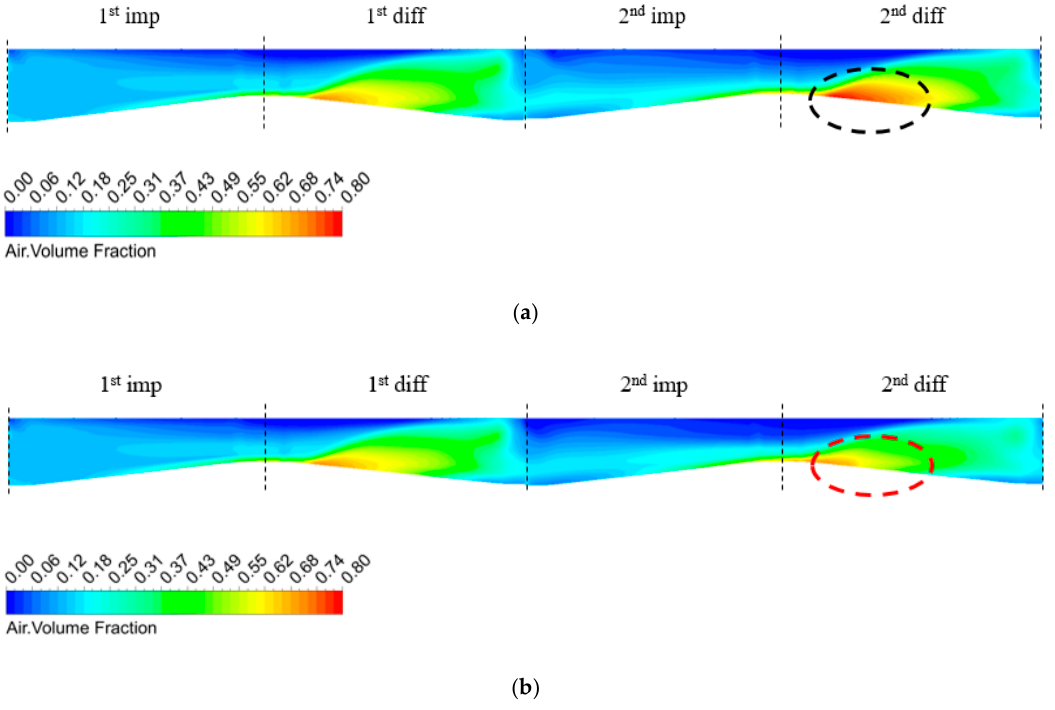
Figure 15. Air volume fraction on the meridional plane at GVF 15%. ( a ) 2nd base model; ( b ) 2nd optimum model.